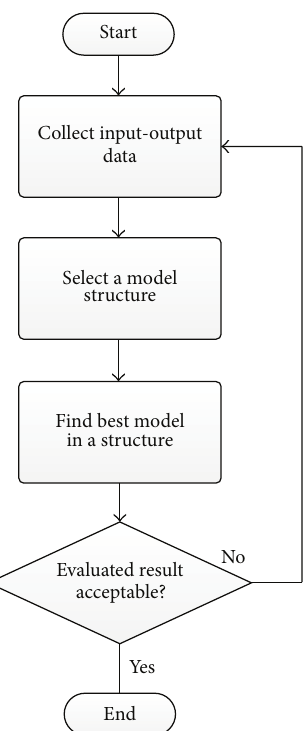
Figure 6: Flowchart for system identification procedure.